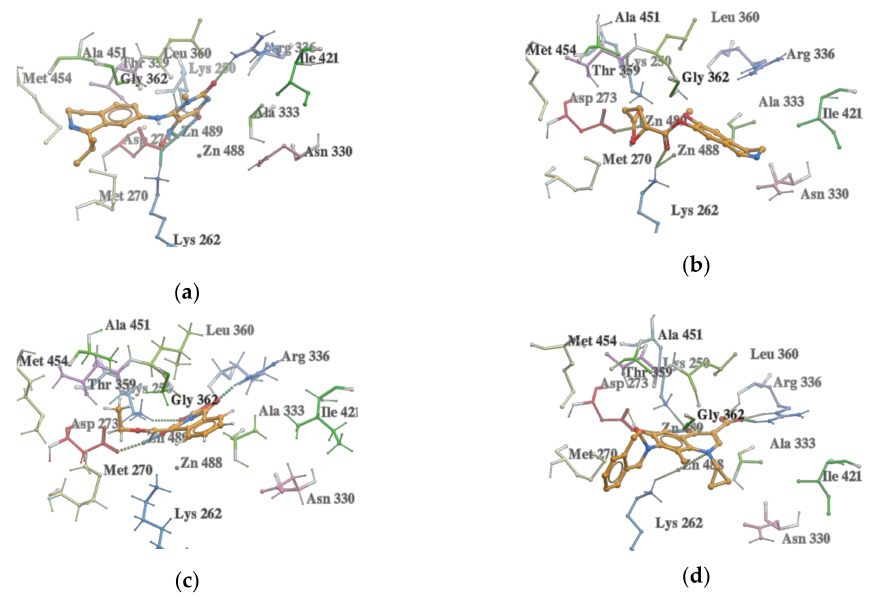
Figure 3. Interactions of the selected compounds with the best binding score values with amino acid residues and zinc ions in the leucine aminopeptidase (LAP) binding pocket. ( a ) 4-hydroxy-1- methyl-5-nitroso-6-{[1-(propan-2-yl)-3,4-dihydroisoquinolin-7-yl]amino}pyrimidin-2(1H)-one (score value of − 51; ZINC database); ( b ) 4-hydroxy-5-[(6-hydroxy-3,4-dihydroisoquinolin-7-yl)oxy]-5- oxopentanoic acid (score value of − 43.8; ZINC database); ( c ) 1,3-dioxo-4-(ethoxymethylene)-3,4- dihydroisoquinoline-2(1H)-carboxylic acid (score value of − 51.72, PubChem); and ( d ) 1,4-dihydro-1- cyclopropyl-4-oxo-6-hydroxy-7-[3,4-dihydroisoquinoline-2(1H)-yl]-8-methylquinoline-3-carboxylic acid (score value of − 42.93, PubChem).